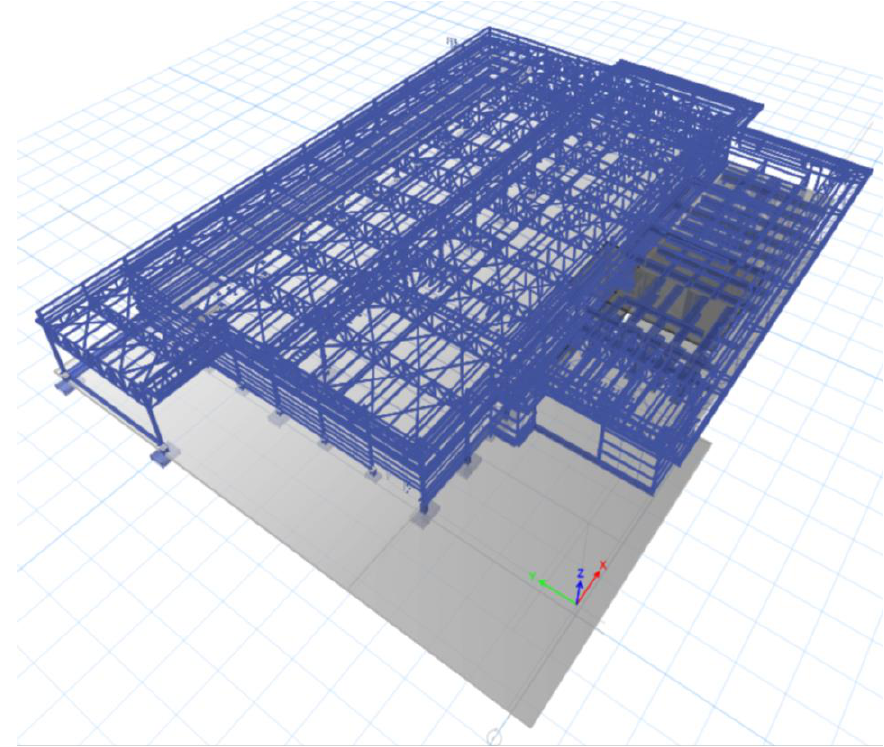
Figure 12. ETABS Model LOD 200 — Study sample.